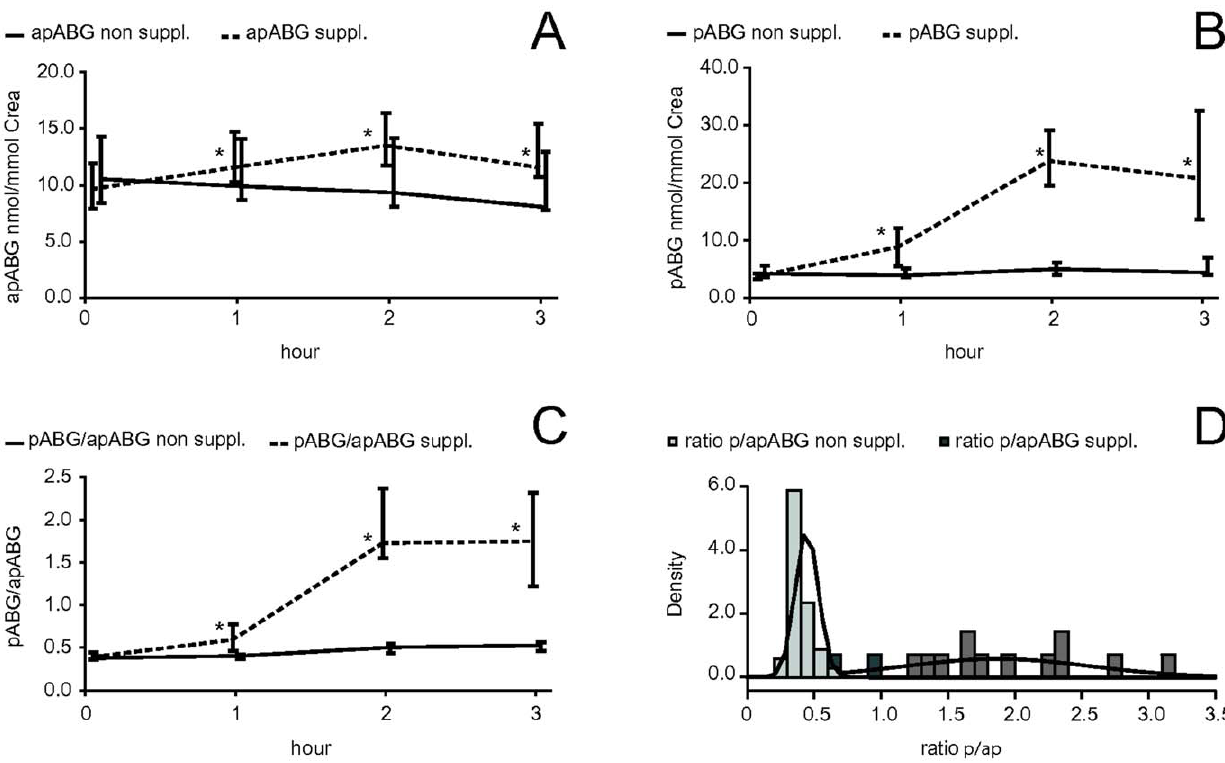
Figure 2. Time course of urinary apABG and pABG after folic acid intake (short-term study). Time course (medians, error bars=inter quartile range (IQR)) of urinary apABG (nmol/mmol creatinine) (A) and pABG (nmol/mmol creatinine) (B), in fasted state (black line) and after oral intake of 400 m g folic acid (dashed line) during the first three hours. (C) Time course of the ratio between pABG and apABG (ratio p/ap ) in spot urine without (black) and with (dashed line) intake of folic acid at time 0. Significant differences from time point 0 are marked with an asterisk (*: p # 0.05, Wilcoxon’s test). (D) Histograms of observed frequencies of ratio p/ap in spot urine in non-dosed state (light grey bars) and 2 h after oral folate intake (dark grey bars), displayed with continuous kernel density function estimates (black